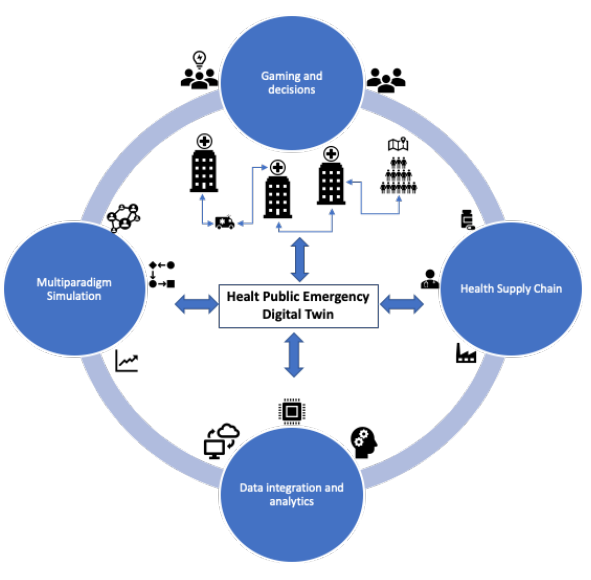
Figure 6. Digital Health Public Emergency System